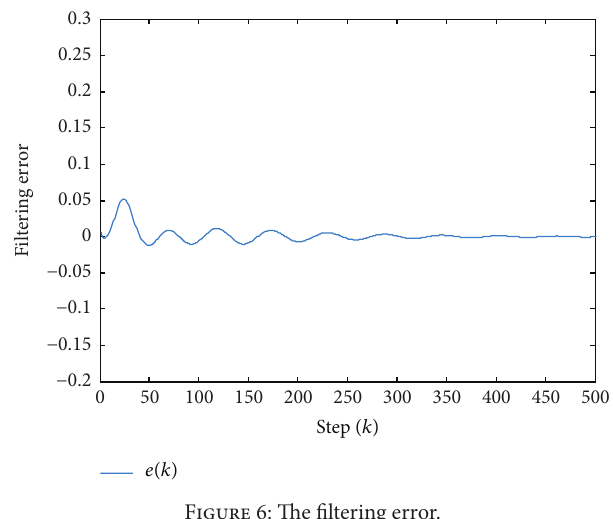
Figure 6: The filtering